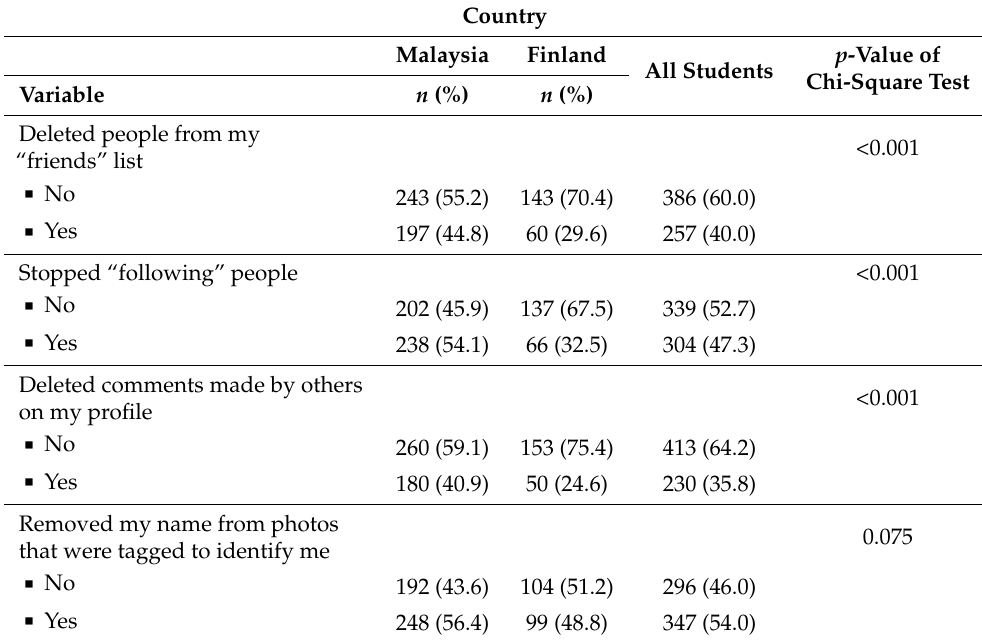
Table 2. Frequency and percentage distributions of responses to the question “What action have you taken if you have found information that you believe should not be publicly available?” by country. Table 1. The frequency and percentage distributions of basic characteristics among study partici ‐ Data include dental undergraduate students from Malaysia ( n = 440) and Finland ( n = 203). pants from Malaysia ( n = 440) and Finland ( n = 203). Statistical significances between countries were Table 1. The frequency and percentage distributions of basic characteristics among study partici ‐ evaluated by chi ‐ square test. Country pants from Malaysia ( n = 440) and Finland ( n = 203). Statistical significances between countries were evaluated by chi ‐ square test. p -Value of Malaysia Finland Table 1. The frequency and percentage distributions of basic characteristics among study partici ‐ All Students Chi-Square Test pants from Malaysia ( n = 440) and Finland ( n = 203). Statistical significances between countries were Variable n (%) Table 1. The frequency and percentage distributions of basic characteristics among study partici ‐ evaluated by chi ‐ square test. pants from Malaysia ( n = 440) and Finland ( n = 203). Statistical significances between countries were <0.001 evaluated by chi ‐ square test. “friends” list Table 1. The frequency and percentage distributions of basic characteristics among study partici ‐ pants from Malaysia ( n = 440) and Finland ( n = 203). Statistical significances between countries were Table 1. The frequency and percentage distributions of basic characteristics among study partici ‐ evaluated by chi ‐ square test. pants from Malaysia ( n = 440) and Finland ( n = 203). Statistical significances between countries were evaluated by chi ‐ square test. Table 1. The frequency and percentage distributions of basic characteristics among study partici ‐ pants from Malaysia ( n = 440) and Finland ( n = 203). Statistical significances between countries were Table 1. The frequency and percentage distributions of basic characteristics among study partici ‐ evaluated by chi ‐ square test. pants from Malaysia ( n = 440) and Finland ( n = 203). Statistical significances between countries were evaluated by chi ‐ square